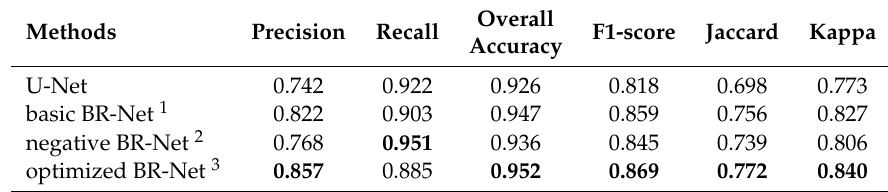
Overall F1-score Jaccard Kappa Accuracy